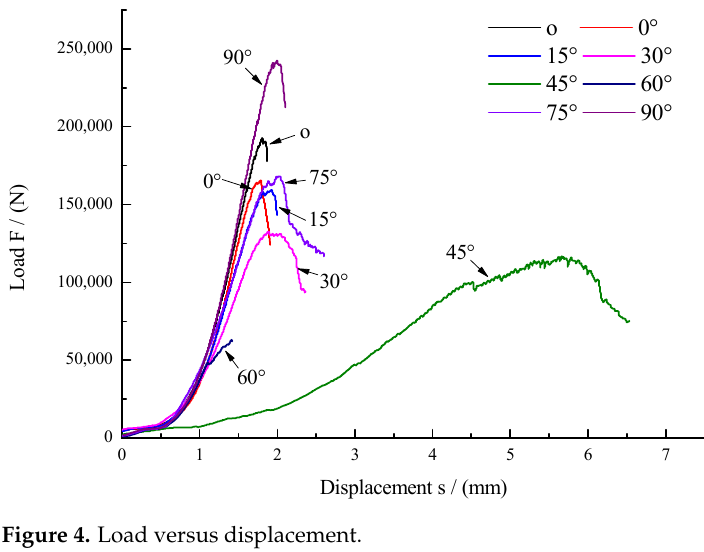
Figure 4. Load versus displacement.